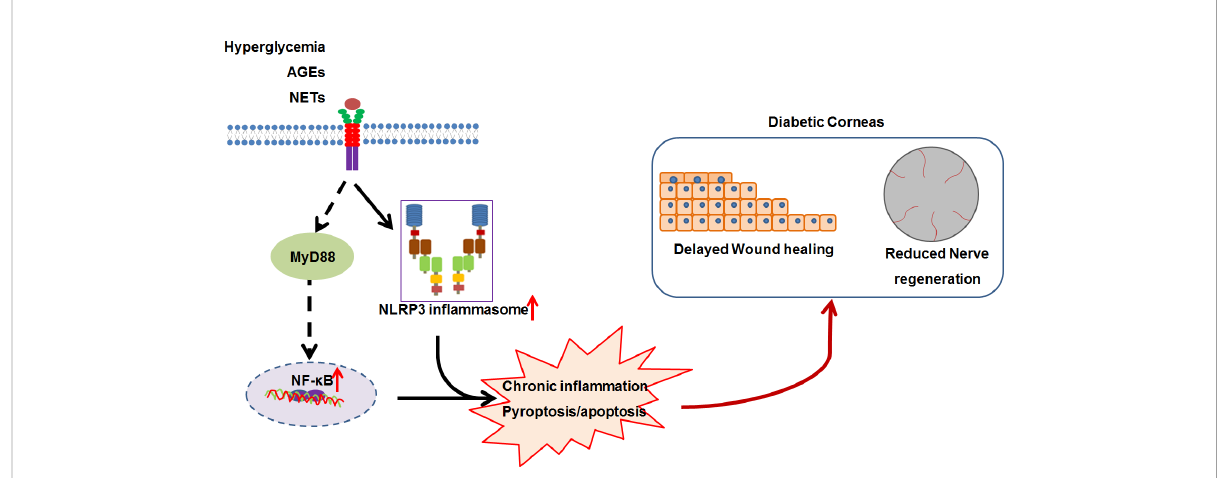
FIGURE 1 The working model for the low-grade chronic in fl ammation contributing to diabetic keratopathy. In diabetic mellitus, numerous diabetes- associated danger molecules (such as hyperglycemia, AGEs and NETs), persistently activate NF- k B signaling and NLRP3 in fl ammasome, resulting in chronic in fl ammation and pyroptosis, which ultimately postpones corneal epithelial wound healing and impairs